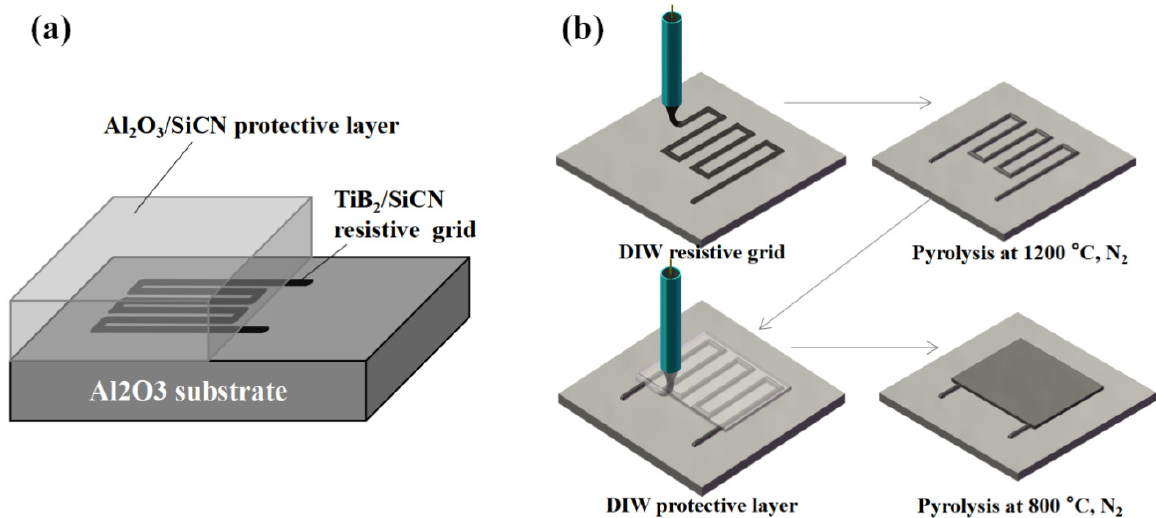
Figure 1. Schematic illustration of ( a ) structure and ( b ) process.